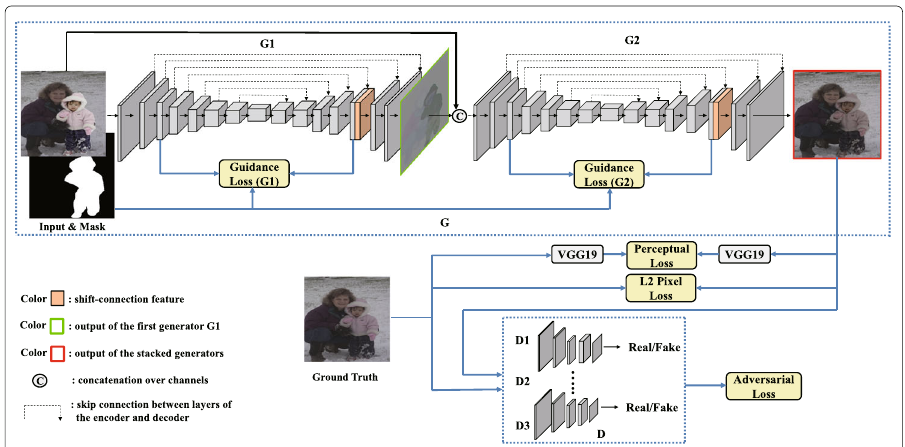
Fig. 2 The overview of the proposed stacked generative adversarial network. It consists of two generators and three discriminators: the output feature map of G 1 is concatenated with the input image and serves as the input of G 2 . The discriminators D 1 and D 2 have an identical network architecture but operate at different image scales. D 2 and D 3 operate at the same image scales but have distinct